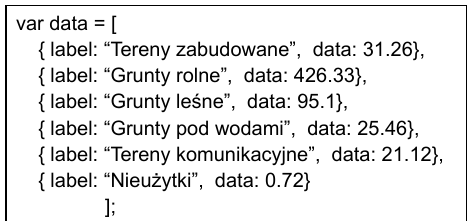
Table 6. Exemplary of Flot chart data array (JavaScript code)